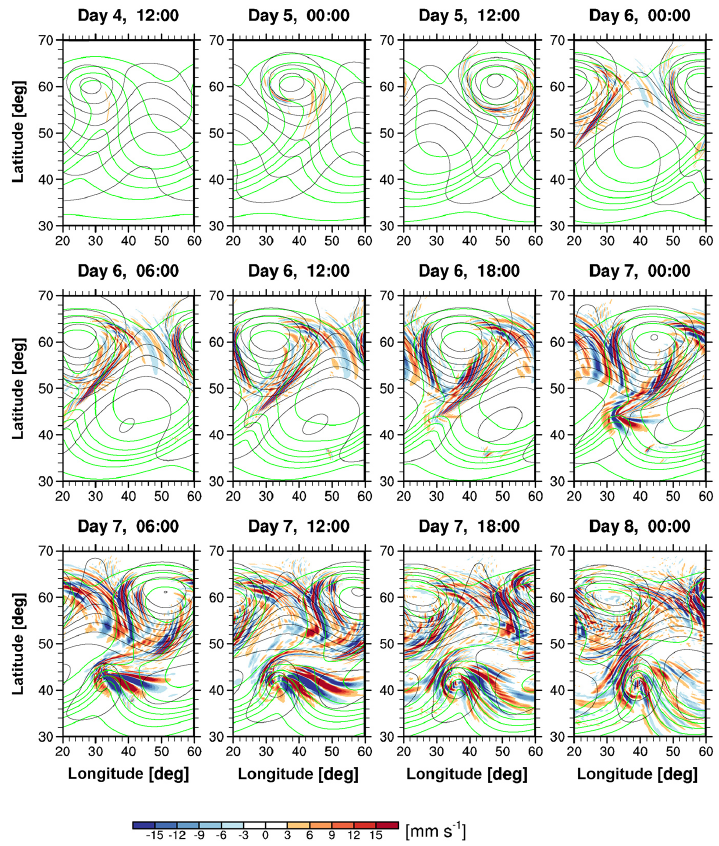
Figure 2. Perturbation vertical velocity ( w (cid:48) ) at z = 8km (shading) superimposed on the 250m background pressure (black) and potential temperature (green) from 12:00UTC on day 4 to 00:00UTC on day 8. The figures are shown with 12h intervals before 00:00UTC on day 6 and with 6h intervals afterward. The contour intervals for the pressure and potential temperature are 8hPa and 8K,